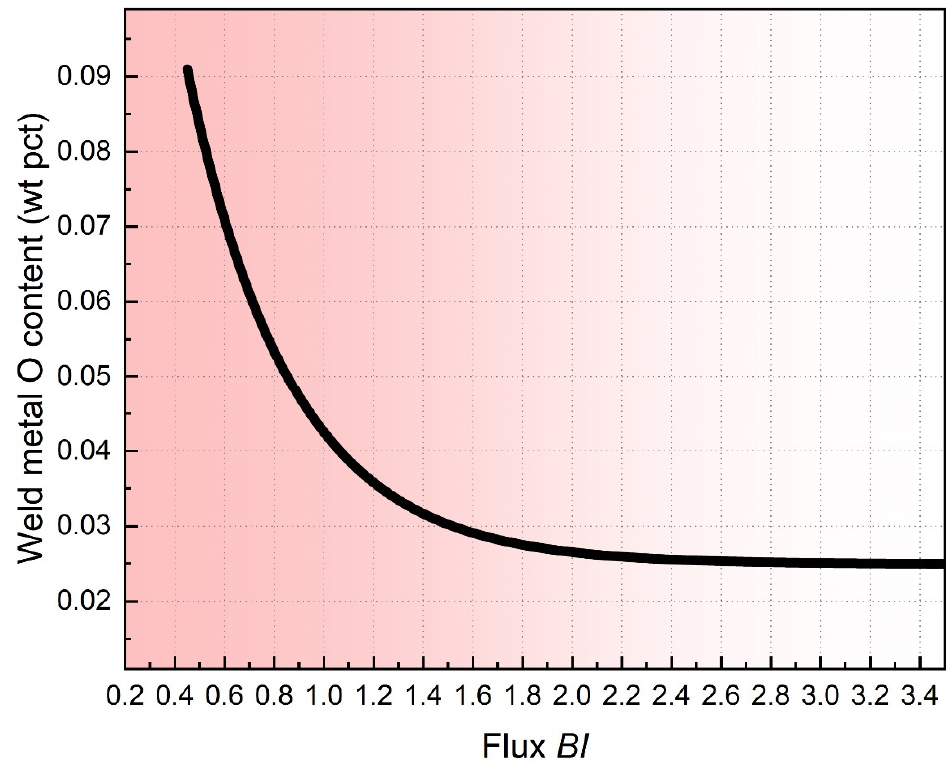
Figure A1. WM O content as a function of flux BI value [24] .